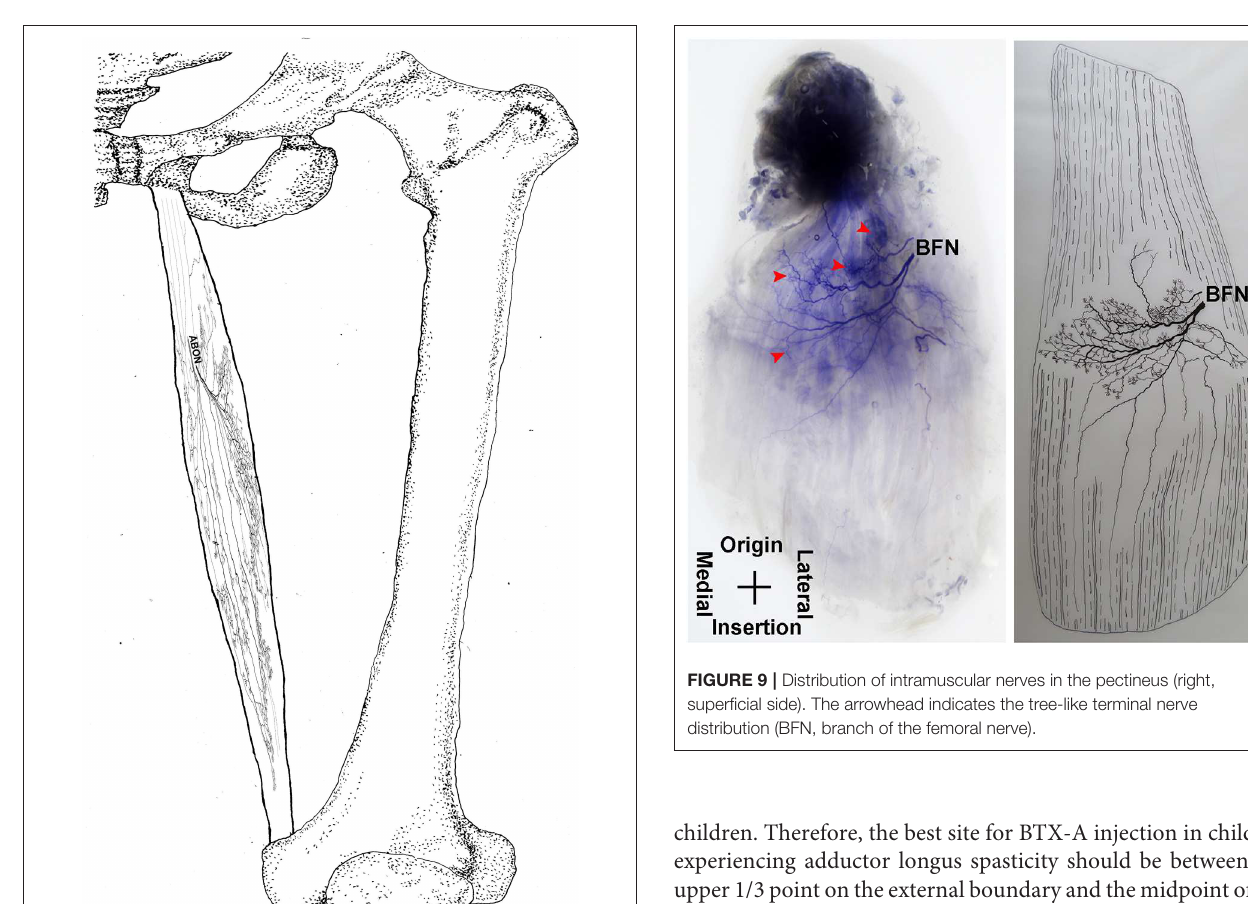
these studies did not provide an ideal guidance for BTX-A